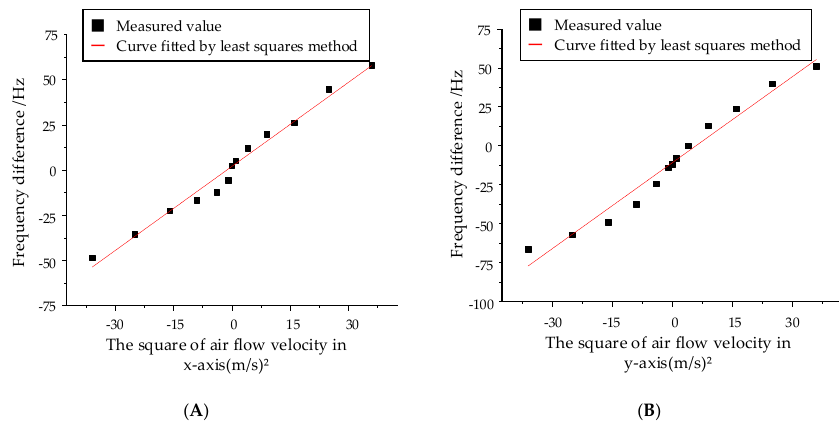
Figure 13. The outputs of the hair flow sensor under steady air flow from 1 m / s to 6 m / s. ( A ) Sensitivity on the x-axis. ( B ) Sensitivity on the y-axis.